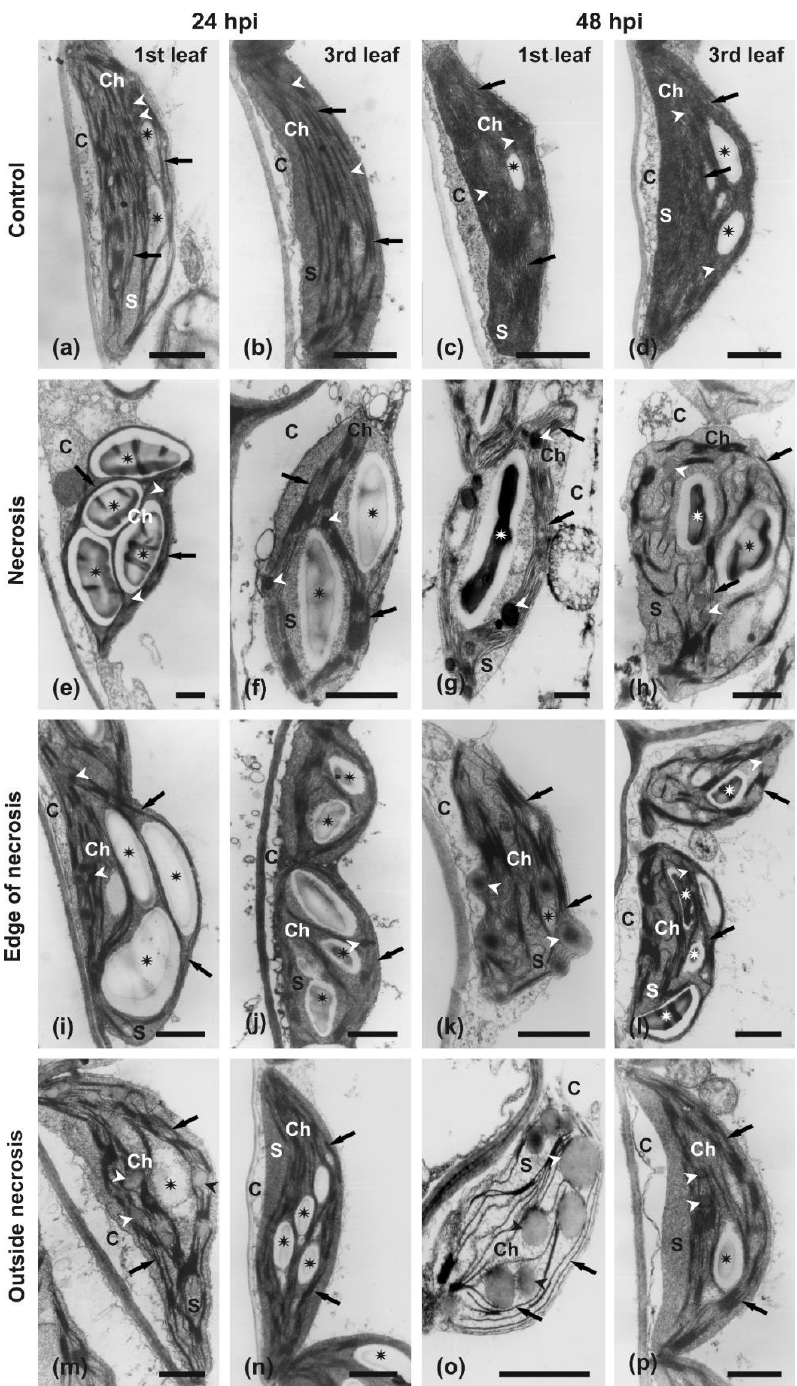
Figure 8. Transmission electron microscopy images showing the ultrastructure of chloroplasts in mesophyll cells from different regions of B. juncea leaves infected with A. brassicicola . Plants were grown under a 16 h day/8 h night regime for 4 weeks and inoculated with A. brassicicola . Samples collected from the 1st ( a , c , e , g , i , k , m , o ) and 3rd leaf ( b , d , f , h , j , l , n , p ) at 24 ( a , b , e , f , i , j , m , n ) and 48 hpi ( c , d , g , h , k , l , o , p ). Electronograms of ultrathin sections taken from control uninfected leaves ( a – d ), inoculation sites — necrosis ( e – h ), edge of necrosis (‘green island’) ( i – l ), and area outside of the necrosis (chlorosis) ( m – p ). Abbreviations: C, cytoplasm; Ch, chloroplast; S, stroma. Arrows indicate thylakoids, arrowheads point to plastoglobules, and asterisks label the starch grains. Scale bars = 1 μ m.